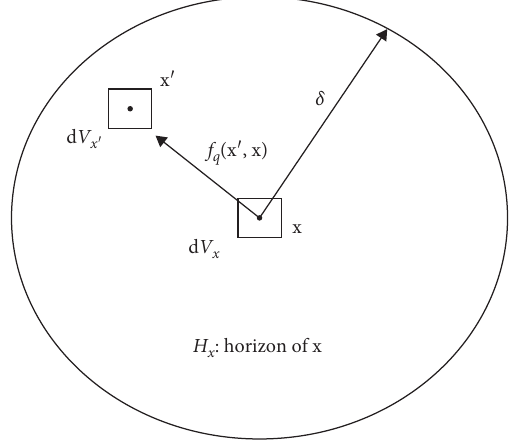
Figure 1: Thermal response